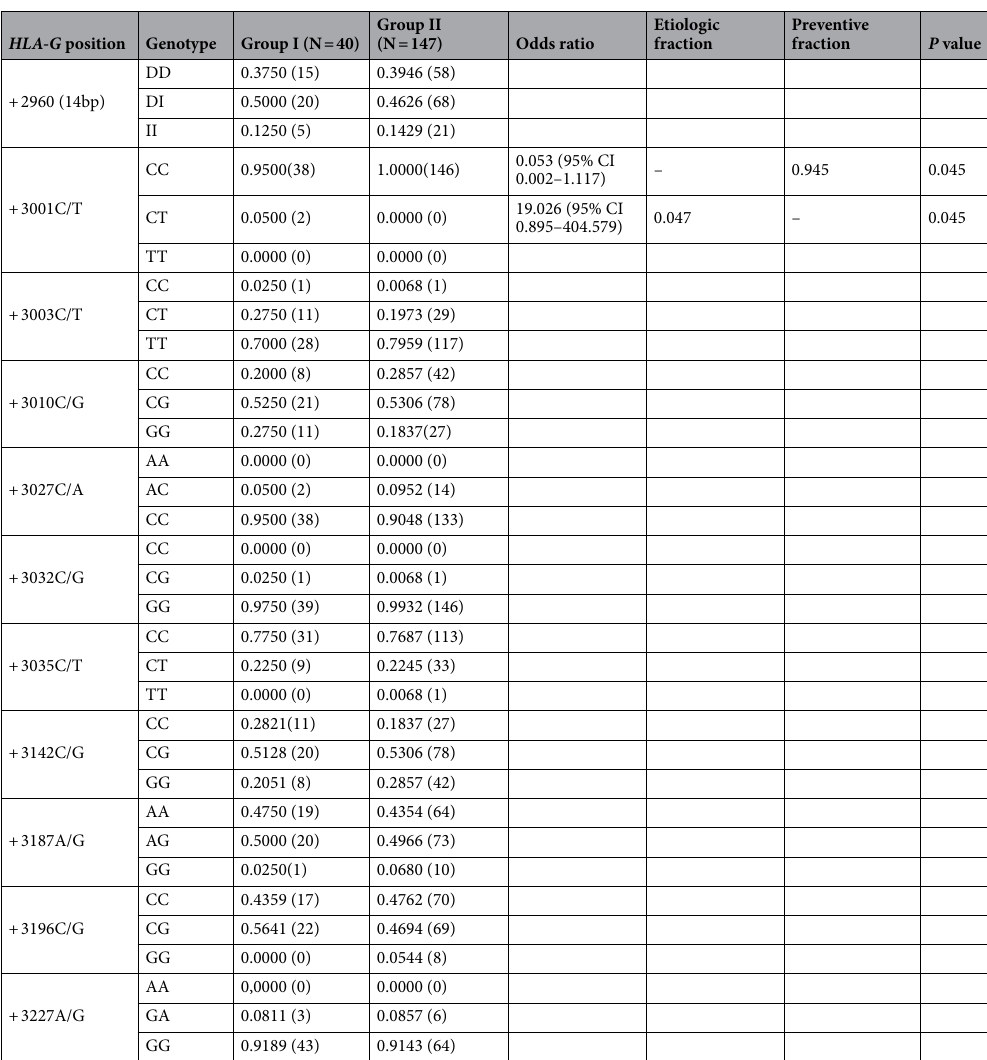
Table 2. Frequency and absolute number of the HLA-G 3 ′ UTR genotypes observed in patients with AIDS exhibiting CMV retinitis (CMV-R: Group I) and in patients with AIDS without CMV-R (Group